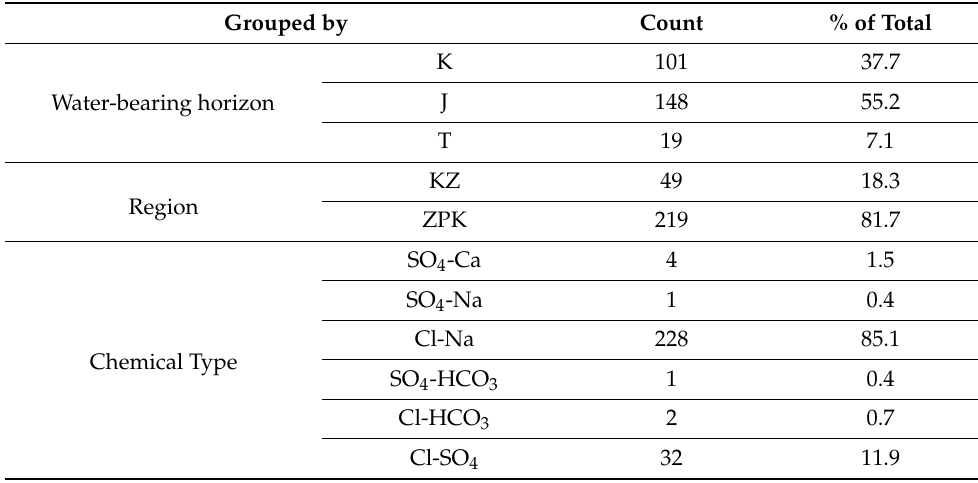
Table 1. The number and percentage of chemical analyses grouped by water-bearing horizon, region, chemical type, depth interval, TDS interval, and estimated depth temperature. Grouped by Count % of Total